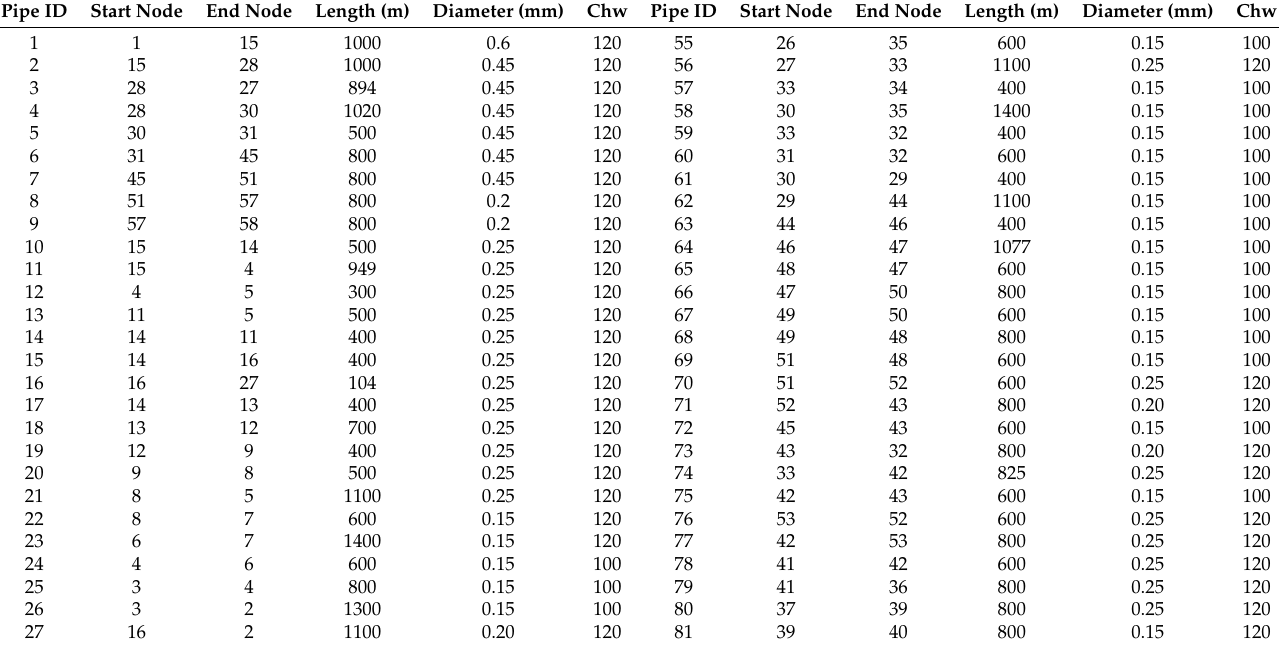
Table A1. Pipe data for case study network